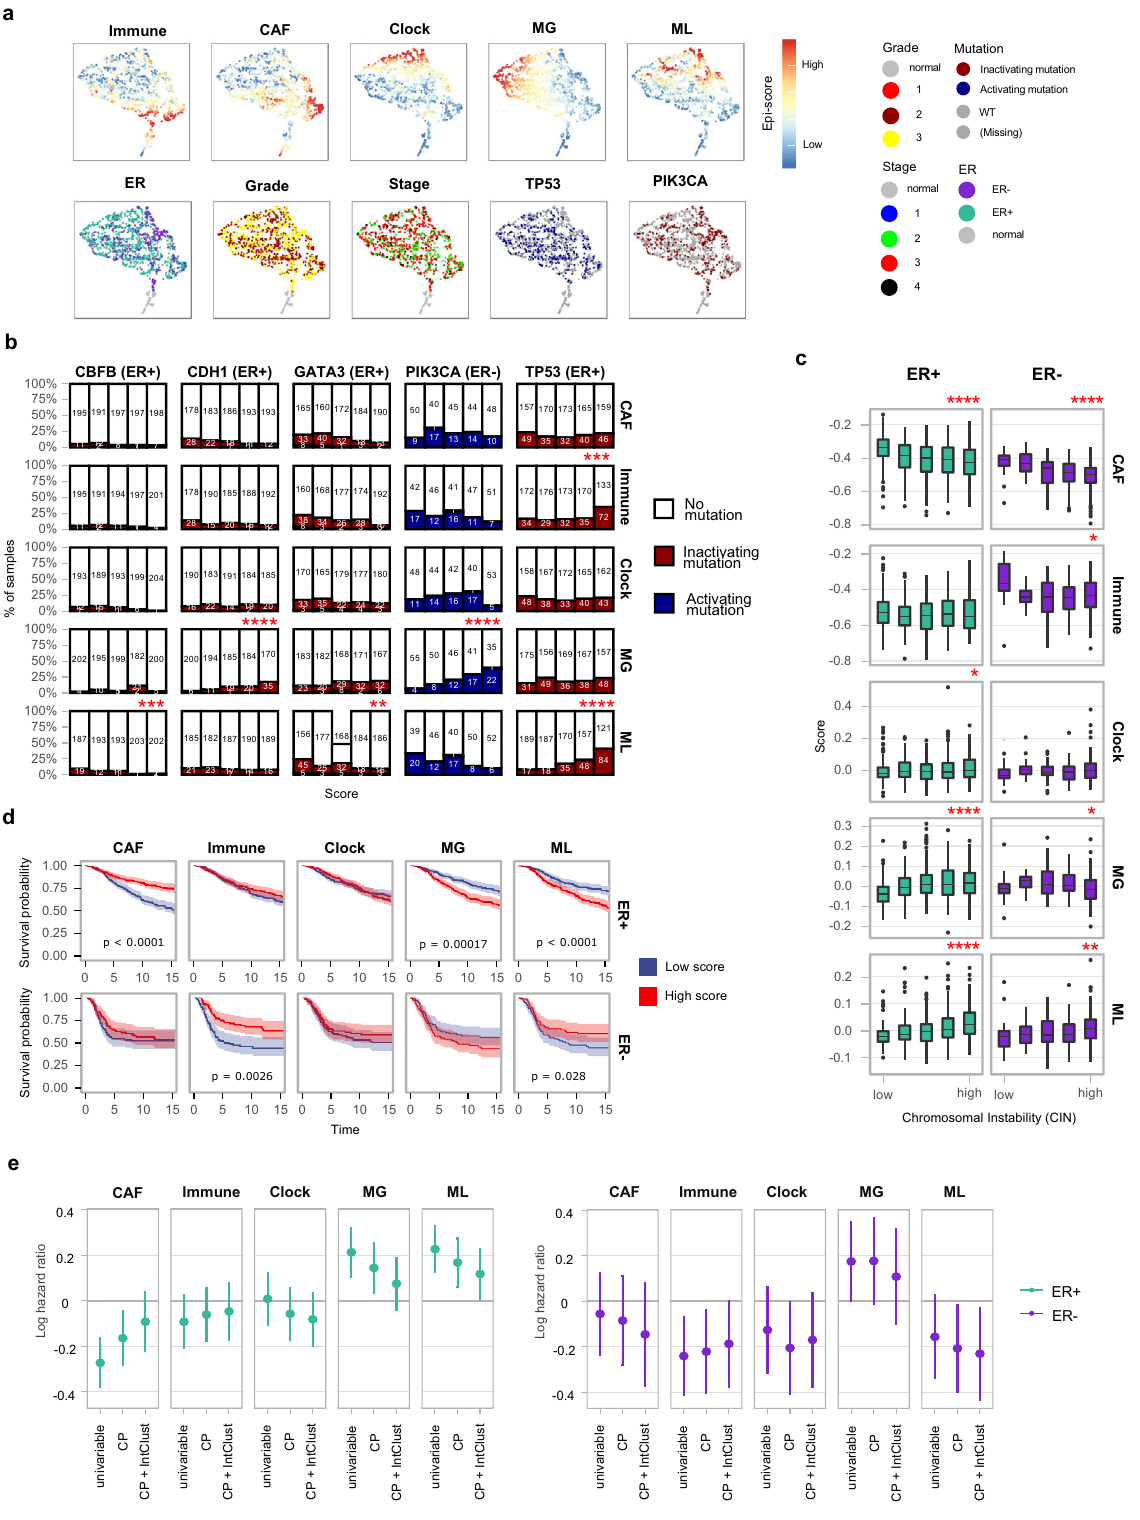
genomic data for association with the fi ve different epigenetic scores. For each epigenetic score, we strati fi ed tumors into fi ve bins and estimated within each bin the penetrance of 171 SNVs (Fig. 4b) and Integrative clusters (Extended Data Fig. 10a). We detected highly signi fi cant correlations with TP53 , PIK3CA , CDH1, GATA3 , and CBFB SNVs (Fig. 4b), and to a lesser degree with